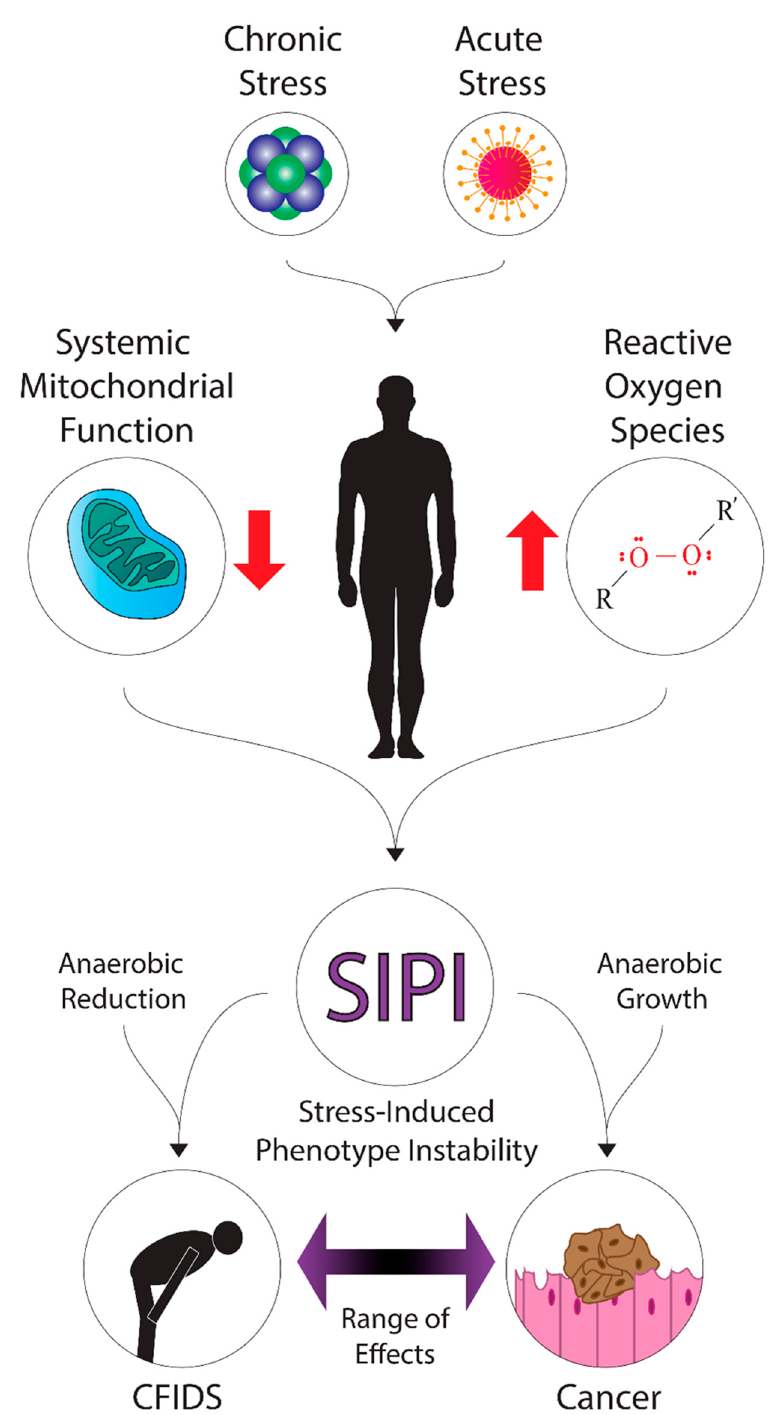
Figure 1. A diagram of the hypothetical mechanisms and effects of stress-induced phenotype instability in cancer and CFS/ME. Various forms of acute stress (such as radiation exposure or infection) or chronic stress may contribute to the systemic dysregulation of energy metabolism and upregulation of oxidative stress. These factors may promote stress-induced phenotype instability in patients, where down- or up-regulation of metabolic pathways could contribute to energy deficits or growth, leading to fatigue symptoms in cancer and CFIDS patients.